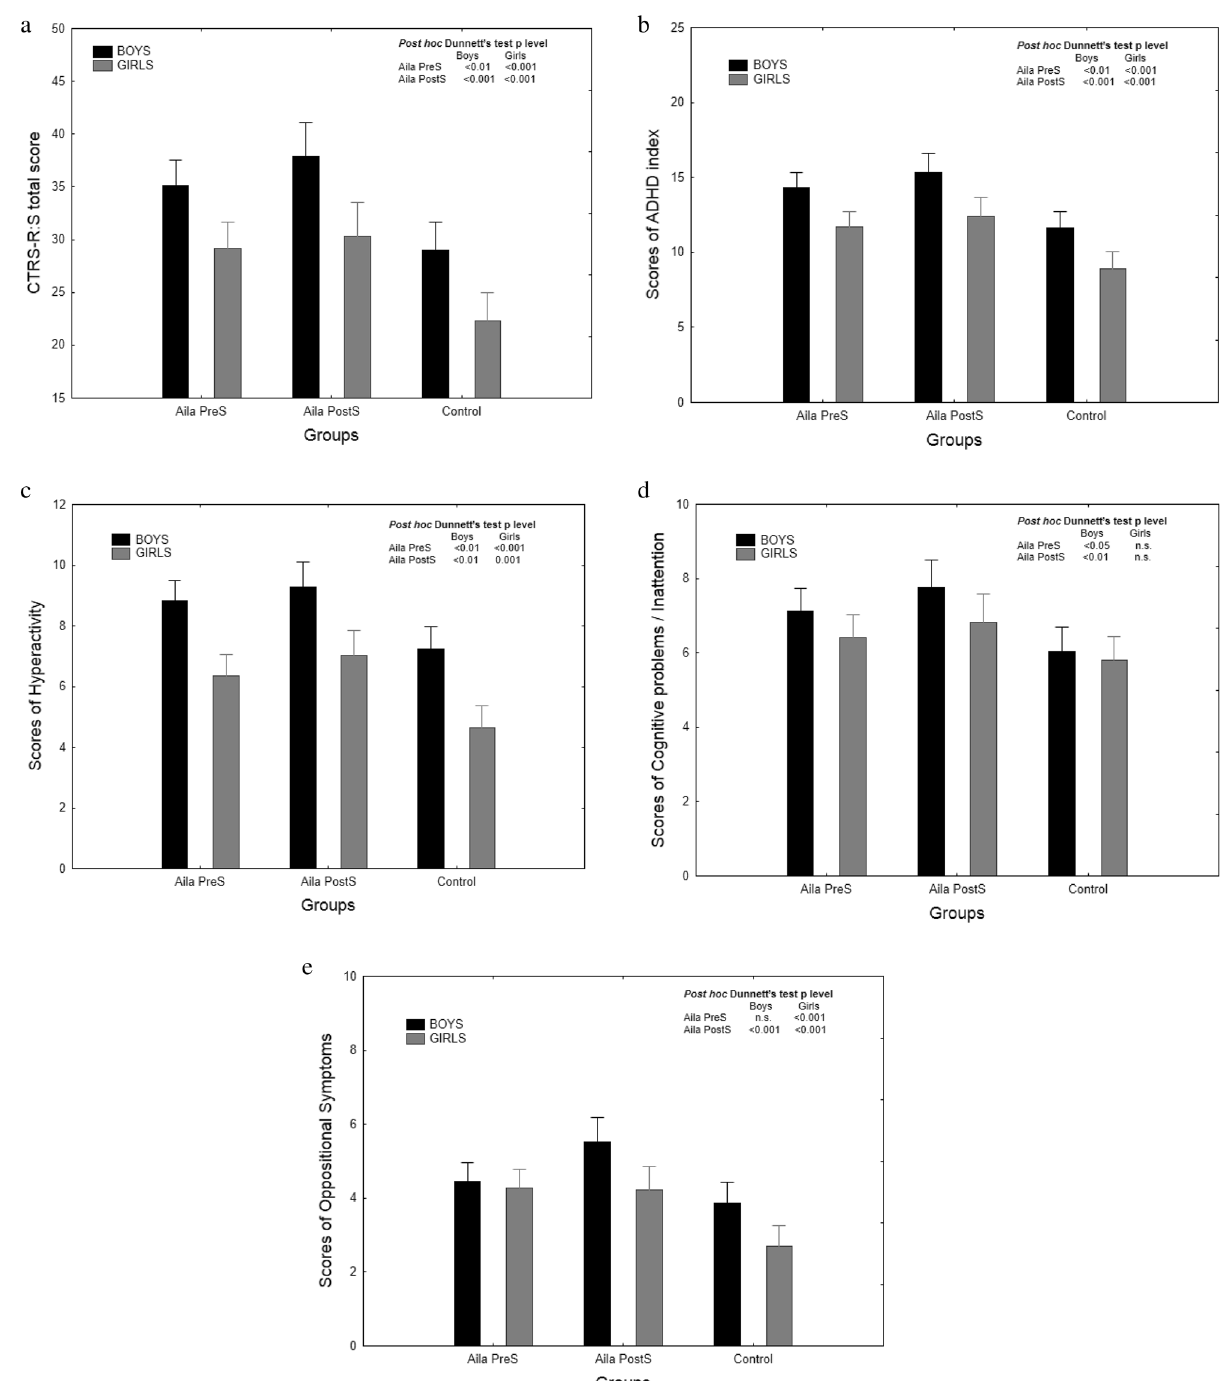
Figure 1. Means, CIs (confidence intervals) and Dunnett’s test results for the total scores of CTRS-R:S ( a ), ADHD Index ( b ), hyperactivity ( c ), cognitive problems/inattention ( d ) and oppositional symptoms ( e ) in boys and girls by two groups of Aila-exposed children and